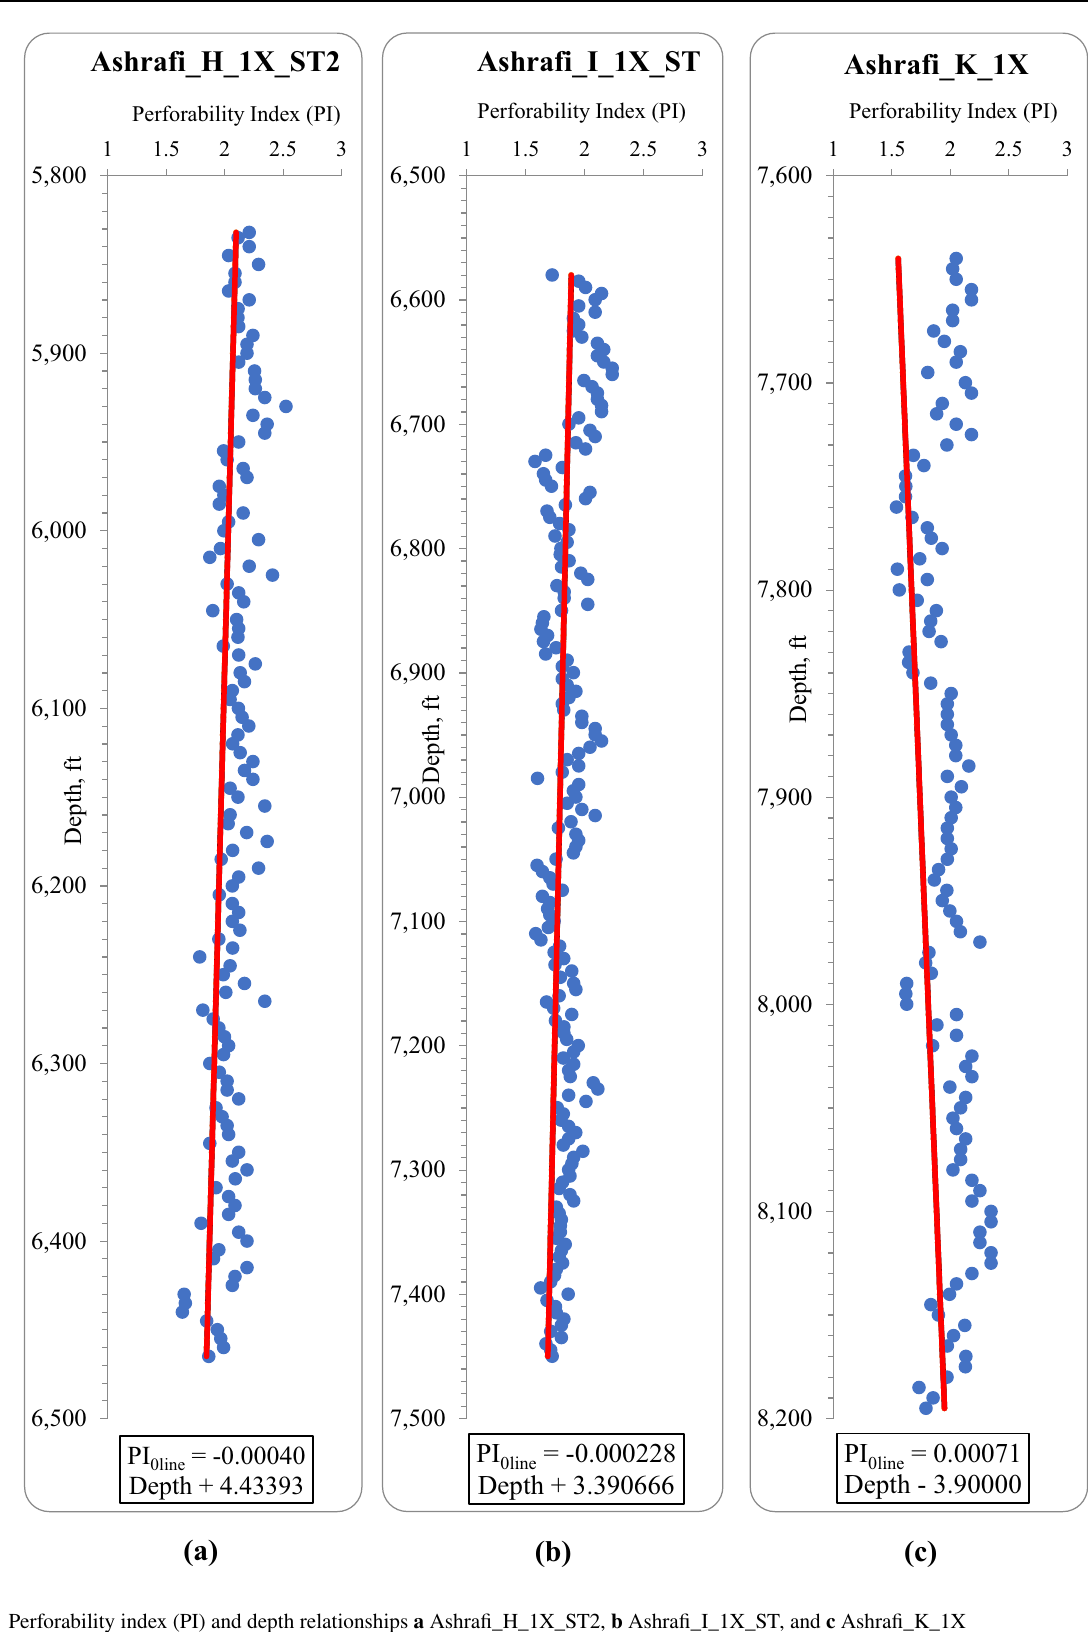
Fig. 11 Perforability index (PI) and depth relationships a Ashrafi_H_1X_ST2, b Ashrafi_I_1X_ST, and c